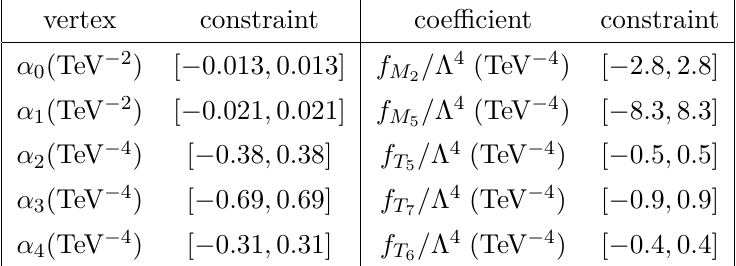
Table 1 . The constraints on anomalous γγWW couplings and the corresponding limits on the dimension-8 operators at 95% CL